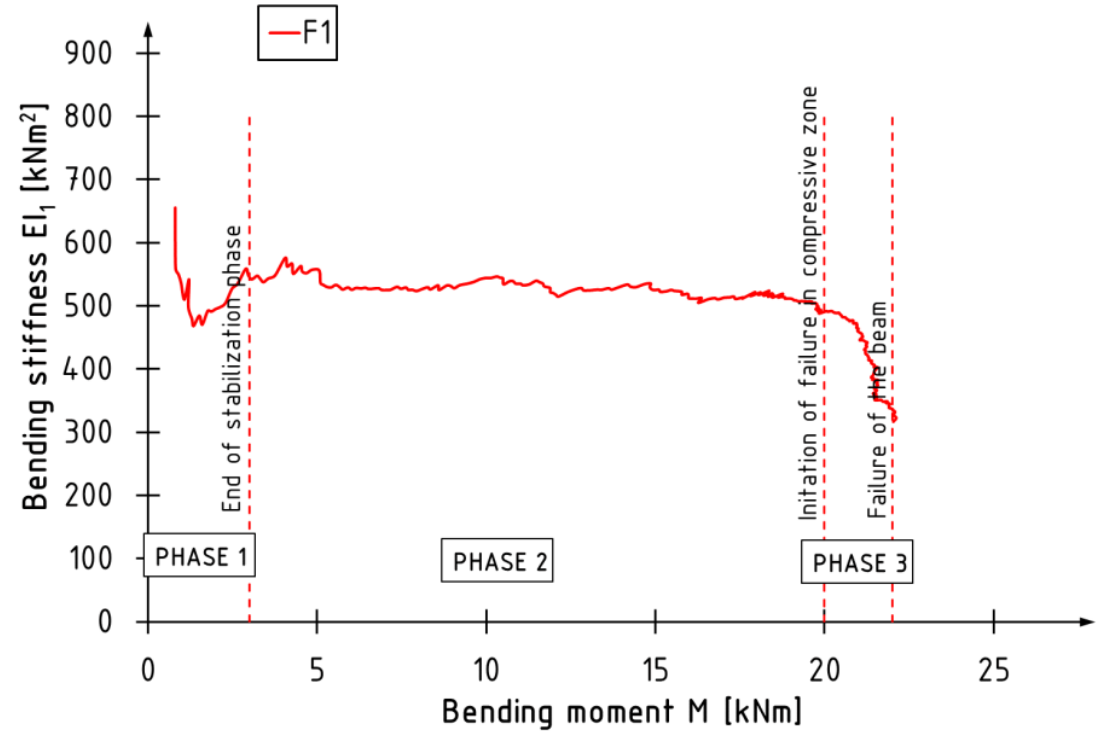
Figure 8. Characteristic phases of bending stiffness changes during bending tests.